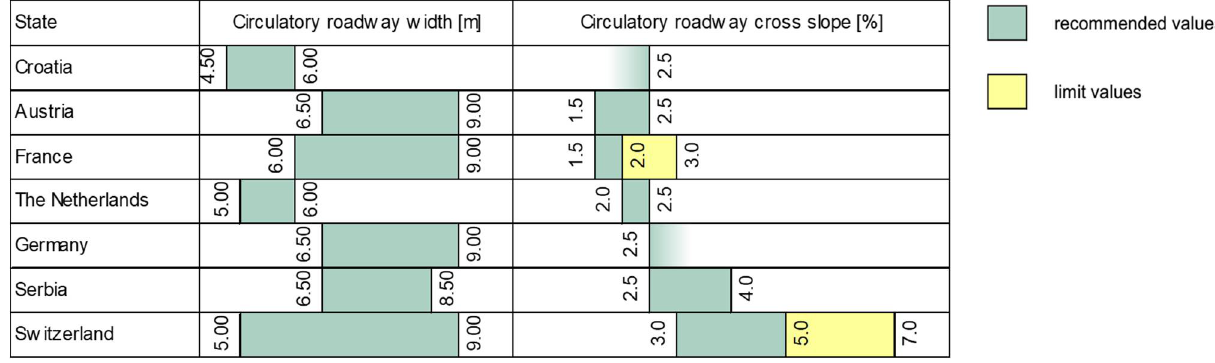
Figure 8. Recommended and limit circulatory roadway widths and cross slope according to [4 – 12].